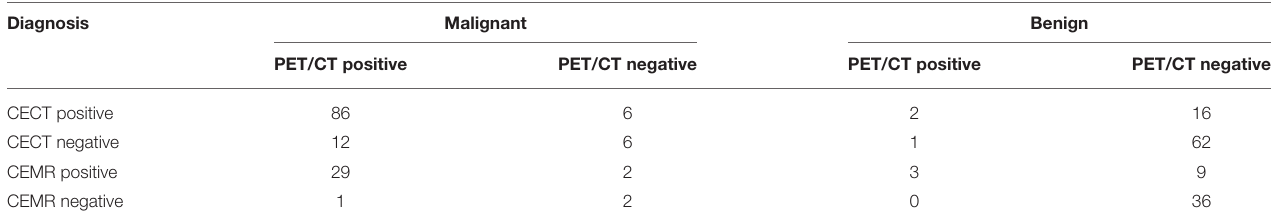
TABLE 5 | Cross-tabulated diagnosis of PET/CT and CECT,